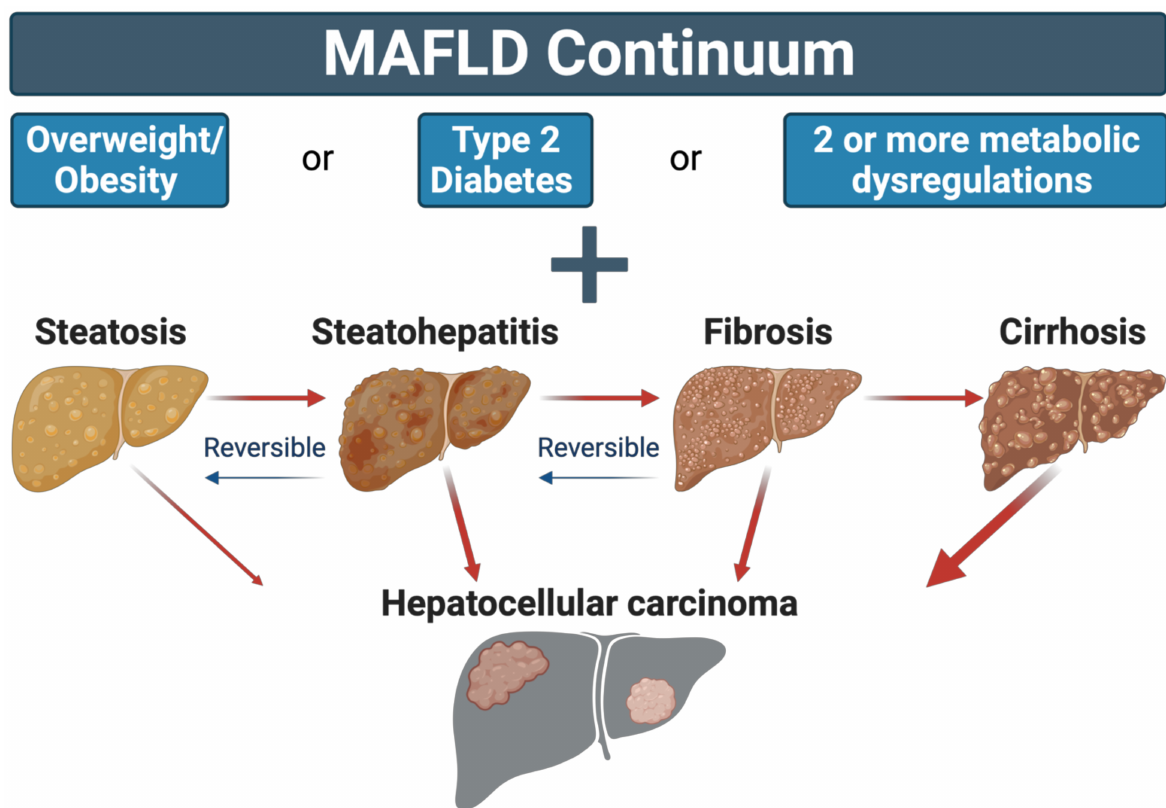
Figure 1. The MAFLD continuum characterizes a spectrum of disease initiated by hepatic lipid accumulation observed in combination with overweight or obesity, type 2 diabetes, or two or more metabolic dysregulations. Across the spectrum, varying severity of MAFLD can independently lead to hepatocellular